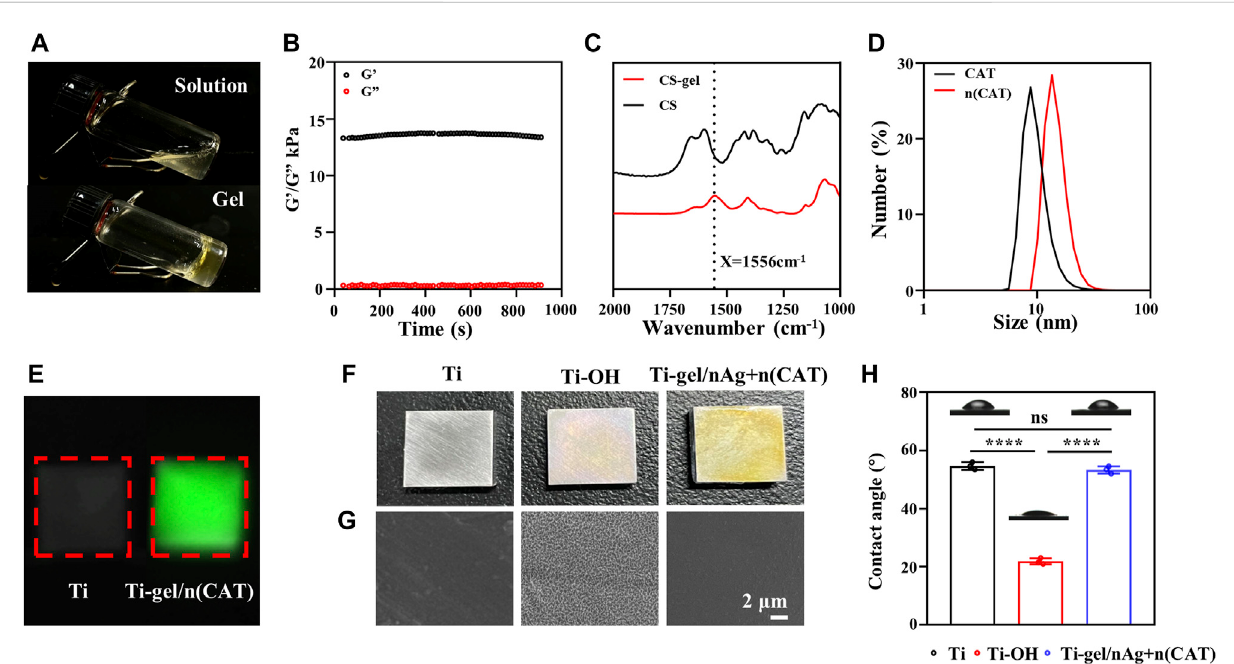
FIGURE 1 Characterization of gel, n (CAT), and Ti-gel/nAg + n (CAT). (A) Physical diagram of the gel. (B) Young ’ s modulus of the gel. (C) FT-IR spectra of chitosanandgel. (D) DSLofCATandn(CAT). (E) FluorescentimagesofTiandTi-gel/n(CAT). (FandG) PhysicaldiagramandSEMofTi,Ti-OH,andTi-gel/ nAg + n (CAT). (H) Ti, Ti-OH, and Ti-gel/nAg + n (CAT) water contact angle. (n = 3, ns means that there are no signi fi cant differences, **** p <